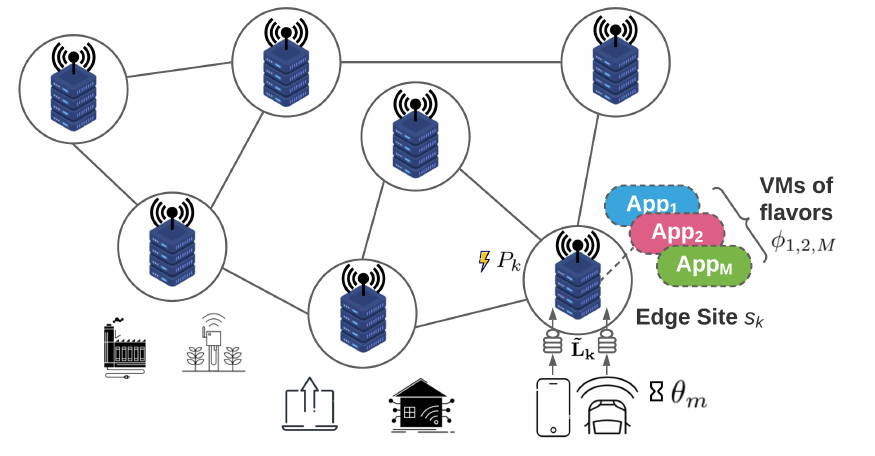
Figure 1. Example of Envisioned Edge